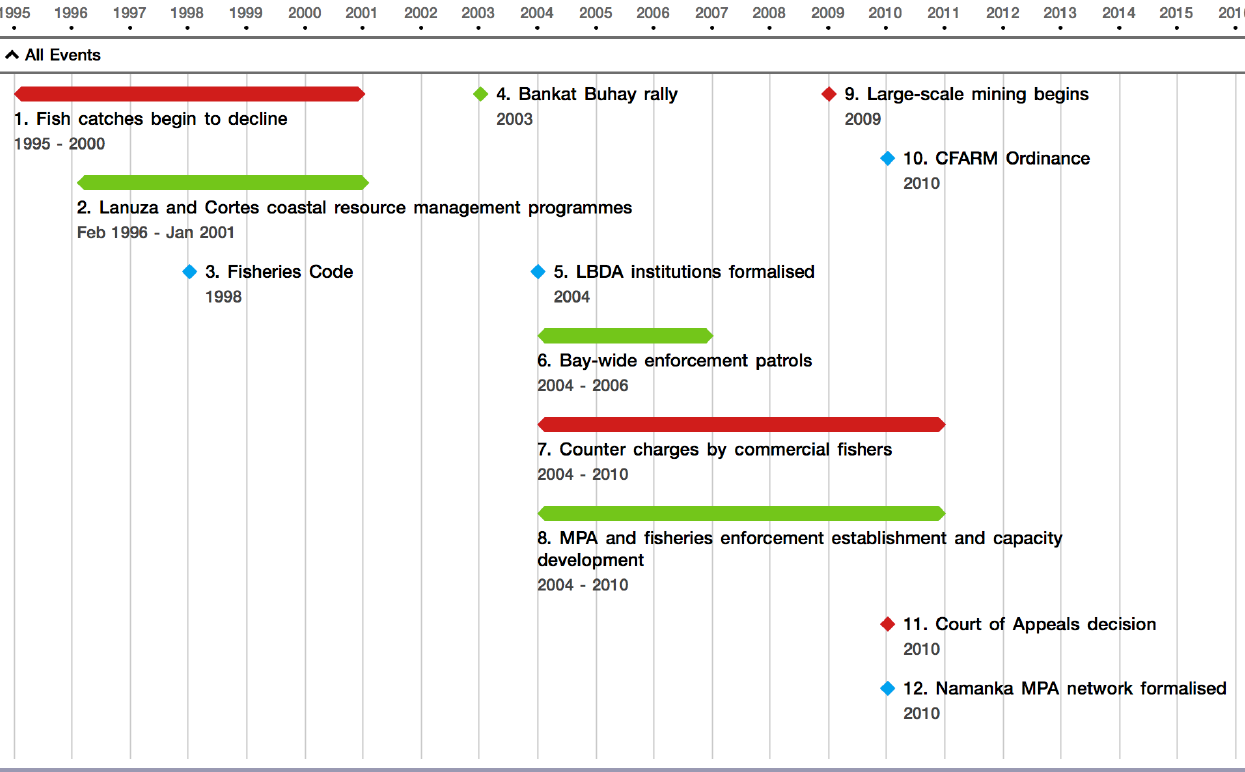
Fig. 3. Key events in the innovation history of Lanuza Bay Development Alliance (LBDA). Red = problems or challenges, blue = institutional developments, green = actions and